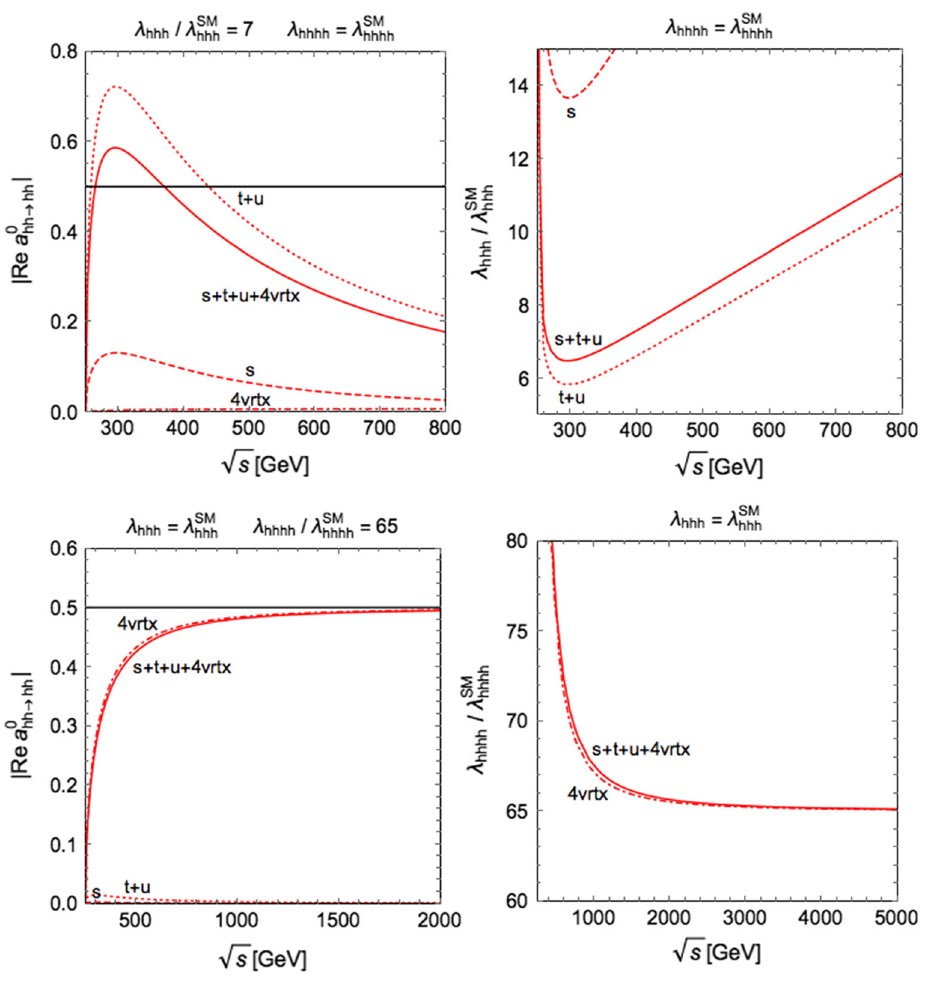
(cid:24) (cid:24) (cid:24) Re a 0 (cid:24) for the ref- λ SM Fig. 3 Up/Left: Kinematical dependence of . Down/Right: Partial-wave unitarity bound hh → hh hhh λ = 7 and λ = λ SM /λ SM erence values λ hhh /λ SM . Up/Right: Partial- as a function of (cid:24) (cid:24) hhhh hhhh hhh hhhh hhhh (cid:24) < 1 / 2 on λ (cid:24) Re a 0 /λ SM dot-dashed and full curves denote, respectively, the s , t + u , 4vrtx and wave unitarity bound as a function hhh √ hh → hh hhh s + t + u + 4vrtx contribution to the partial wave. Note that s and 4vrtx s and for λ hhhh = λ SM of . Down/Left: Kinematical dependence of (cid:24) (cid:24) hhhh (cid:24) for the reference values λ (cid:24) Re a 0 have the opposite sign of t + u (cf. Eq. /λ SM = 65 and λ = hhhh hhh hh → hh hhhh